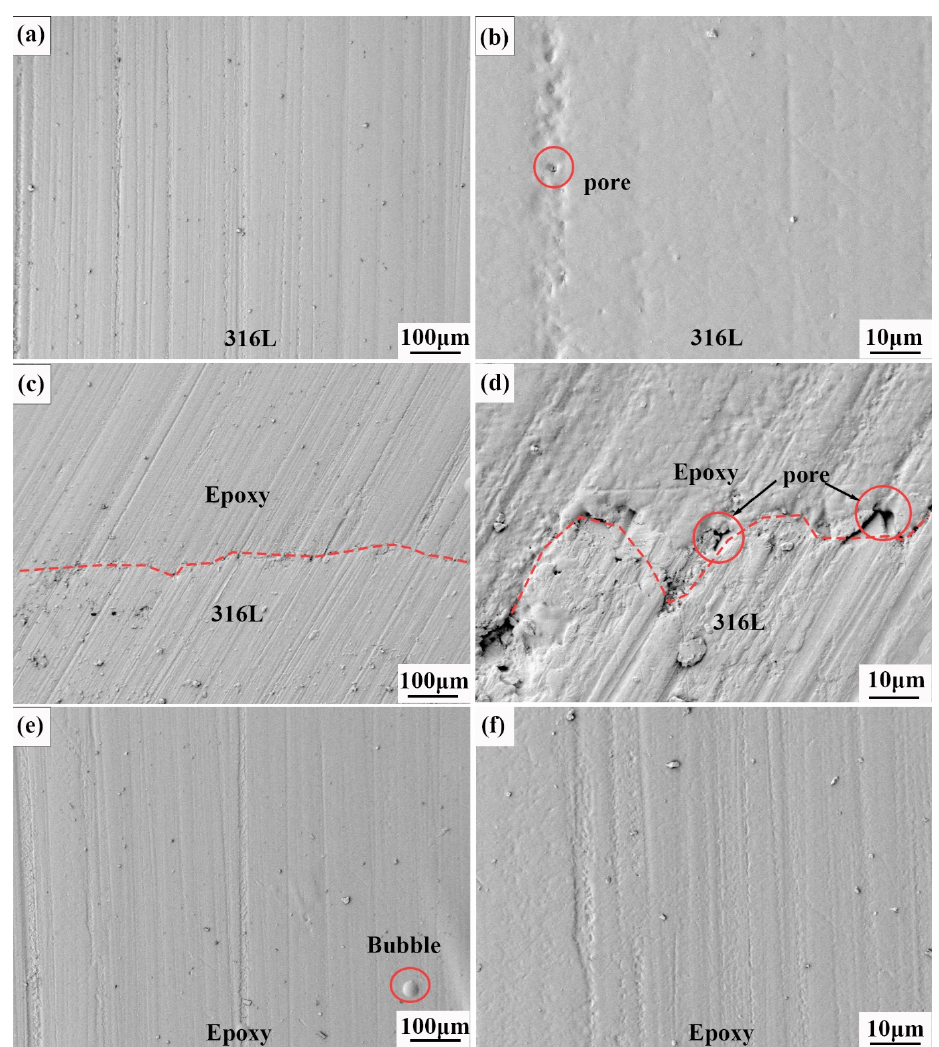
Figure 5. Secondary electron micromorphology of the epoxy/316L metal lattice composites. (a) The SEM of the 316L matrix. (b) The SEM of the 316L matrix including some pore defect. (c) The SEM of the interface between 316L and epoxy. (d) The SEM of the interface between 316L and epoxy includ ‐ ing pore defects. (e) The SEM of the epoxy with bubble defects. (f) The SEM of the epoxy matrix. Epoxy is a viscoelastic material whose dynamic mechanical behavior is different from elastic materials such as steel. The stress and strain of steel are almost simultaneous. How ‐ ever, when the alternating stress is applied, its deformation will obviously lag behind the external force of the materials. When the external force changes, the epoxy will move and convert some mechanical energy into heat energy and dissipate, thereby consuming en ‐ ergy. Meanwhile, the interface between epoxy and metal is a weak bonding interface. The interface is not as tight as metal to metal. When the shear stress of the interface is sufficient to overcome the bonding force of the interface, the interface will effectively consume en ‐ ergy.